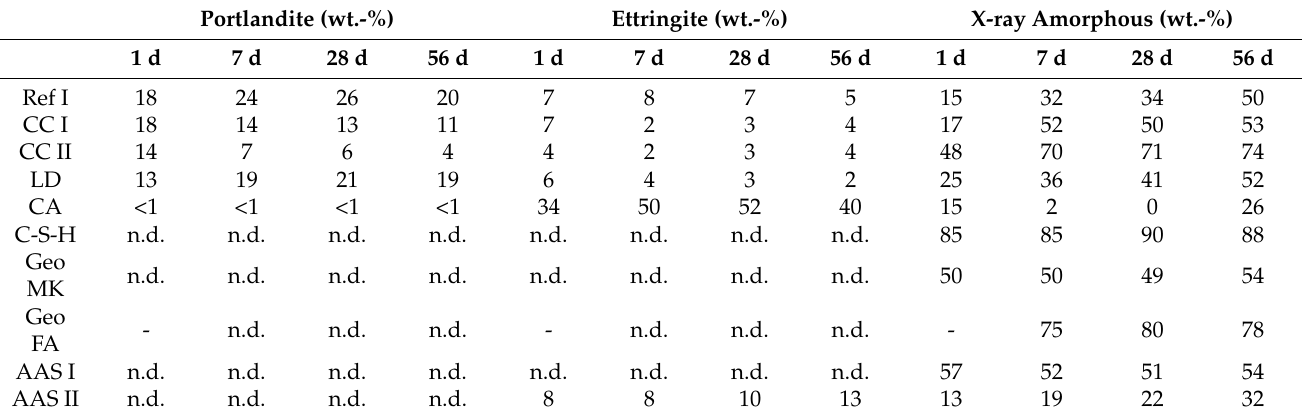
Table 2. Change in portlandite, ettringite and x-ray amorphous amount over 56 d hydration. Portlandite